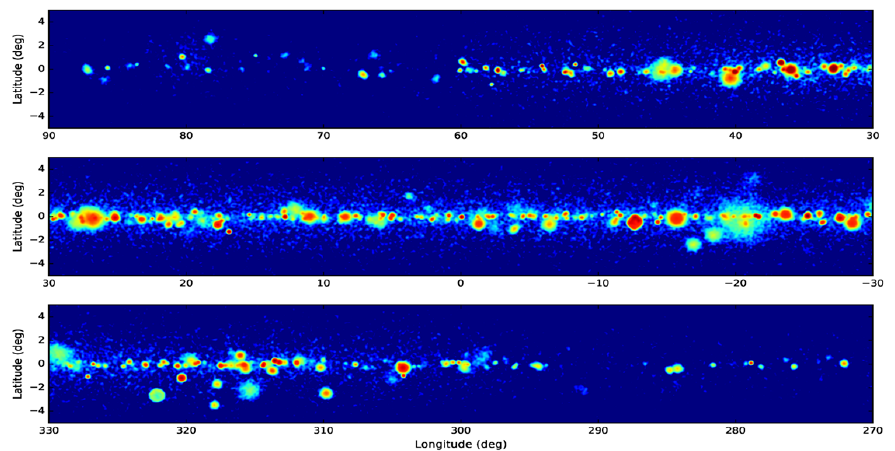
Figure 3. Simulated results from the CTA Galactic Plane Survey in very high-energy gamma rays for half of the plane. The simulation incorporates the proposed GPS observation strategy and a source model containing SNR and PWN populations, as well as di ↵ use